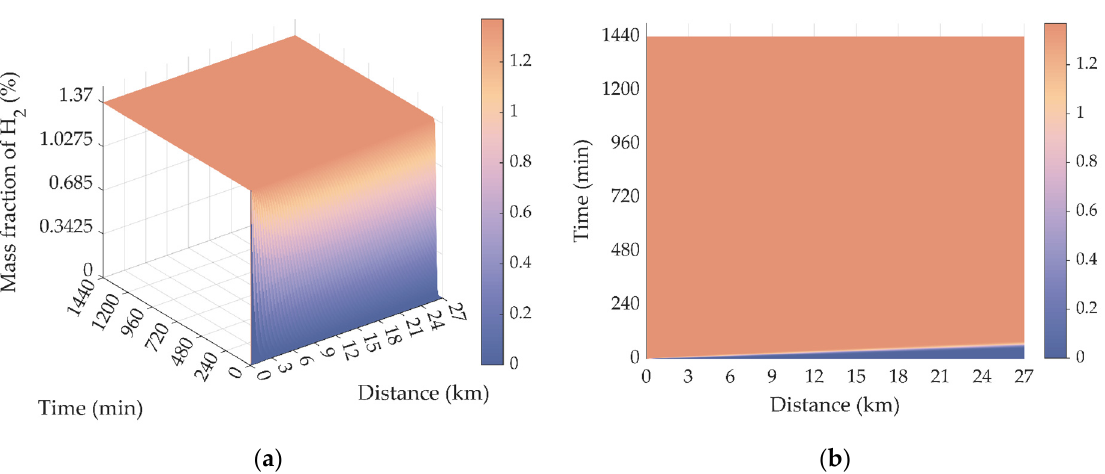
Figure 8. The distribution of hydrogen mass fraction in Pipe 1 in Scenario I: ( a ) Three-dimensional diagram; ( b ) top view.